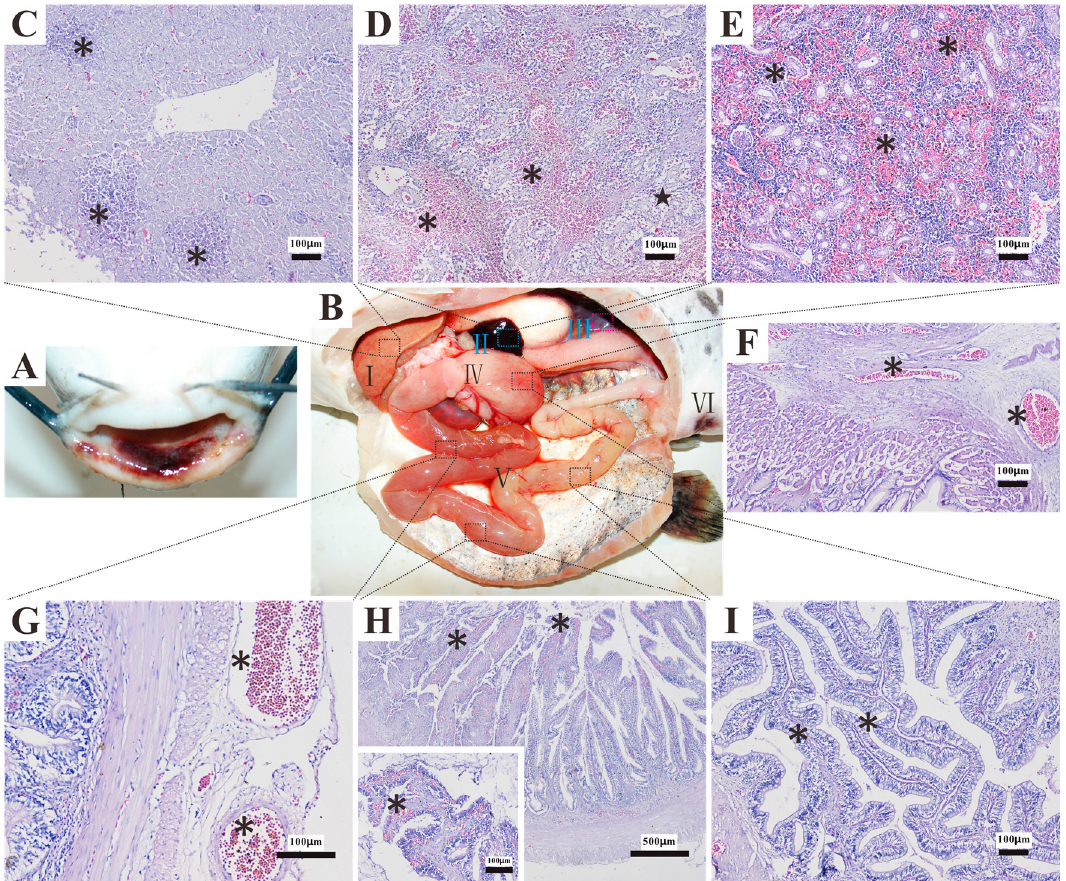
Figure 1. Main symptoms and histopathological changes of the diseased Ictalurus punctatus. ( A ) Mandibular hemorrhage in Ictalurus punctatus infected with Y. ruckeri ; ( B ) enlarged liver ( I ), black spleen ( II ), nephremia ( III ) and reddened intestine and anus (IV, V, VI); ( C ) liver coagulation necrosis, necrosis area ( * ); ( D ) spleen hemorrhage ( * ) and edema ( ★ ); ( E ) renal interstitium hemorrhage ( * ); ( F ) mucosa and serosa of stomach hyperemia ( * ); ( G ) intestinal serosa hyperemia ( * ); ( H ) intestinal epithelial cell causing severe necrosis and fall off, intestinal mucosa hemorrhage ( * ); ( I ) Intestinal villus hyperplasia ( * ). Table 1. General features of the genome of Y. ruckeri SC09.